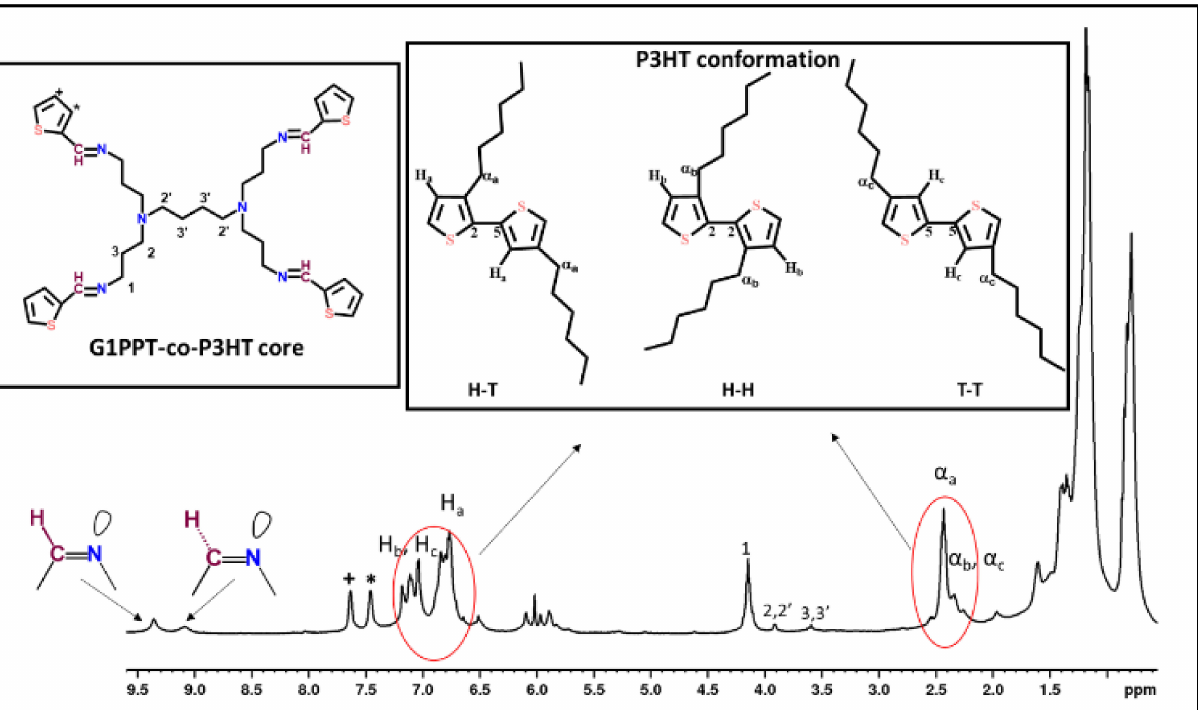
Figure 1. 1 H NMR of generation 1 poly(propylene thiophenoimine)-co-poly(3-hexylthiophene)